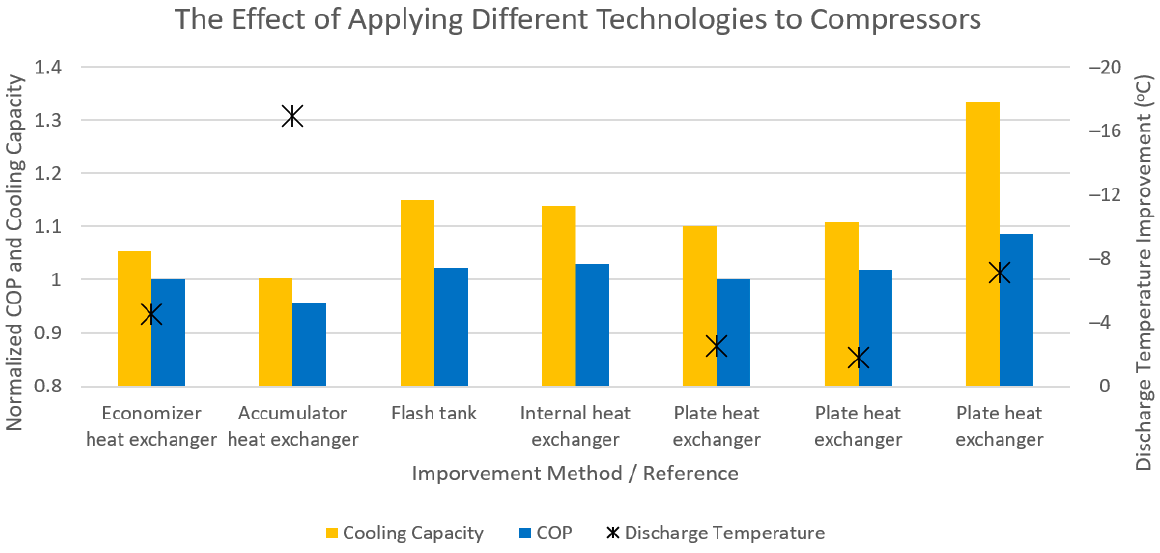
Figure 7. Improvements of different technologies applied to compressors under HAT conditions [54–56,59]. Table 8. Details of compressor improvements for each method.